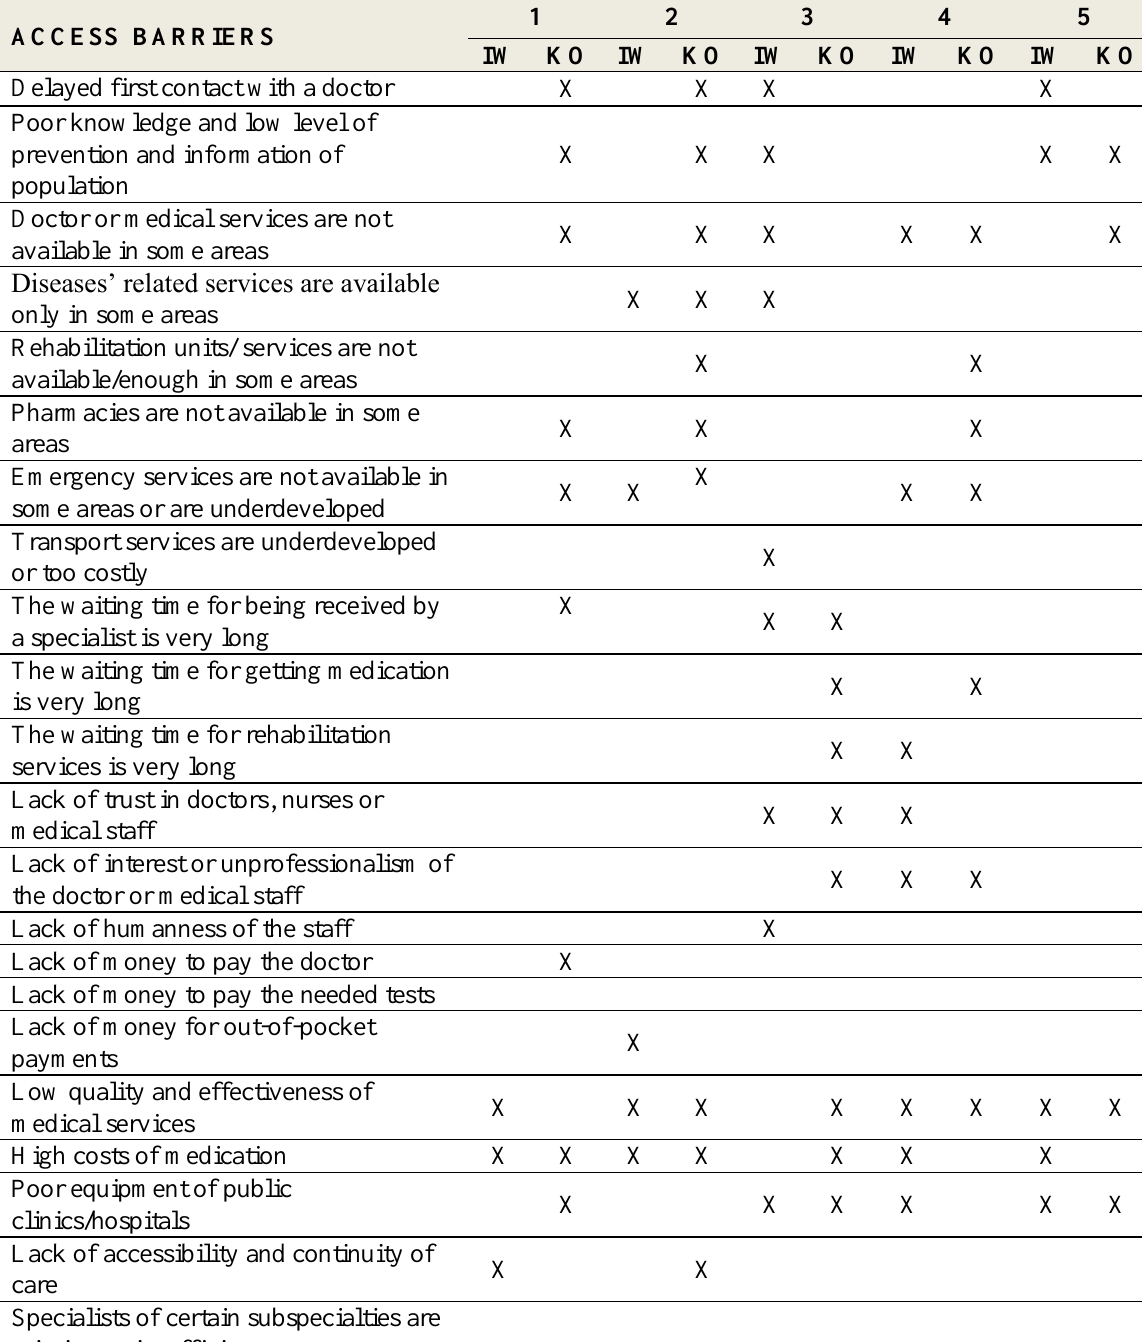
Table 4. Main access barriers in public health care of the five selected health problems ACCESS